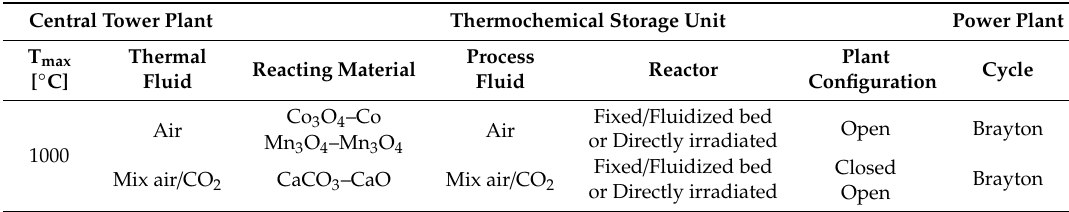
Table 3. Possible design options for the integration of the solar plant and the thermochemical storage